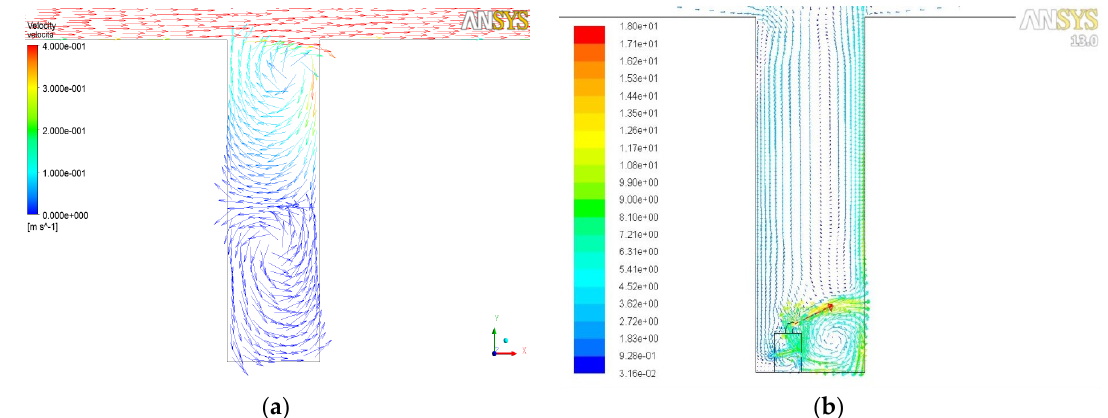
Figure 12. Wind flow pattern in a deep street canyon characterized by an aspect ratio of 3 without ( a ) and with ( b ) the APA scrubber.